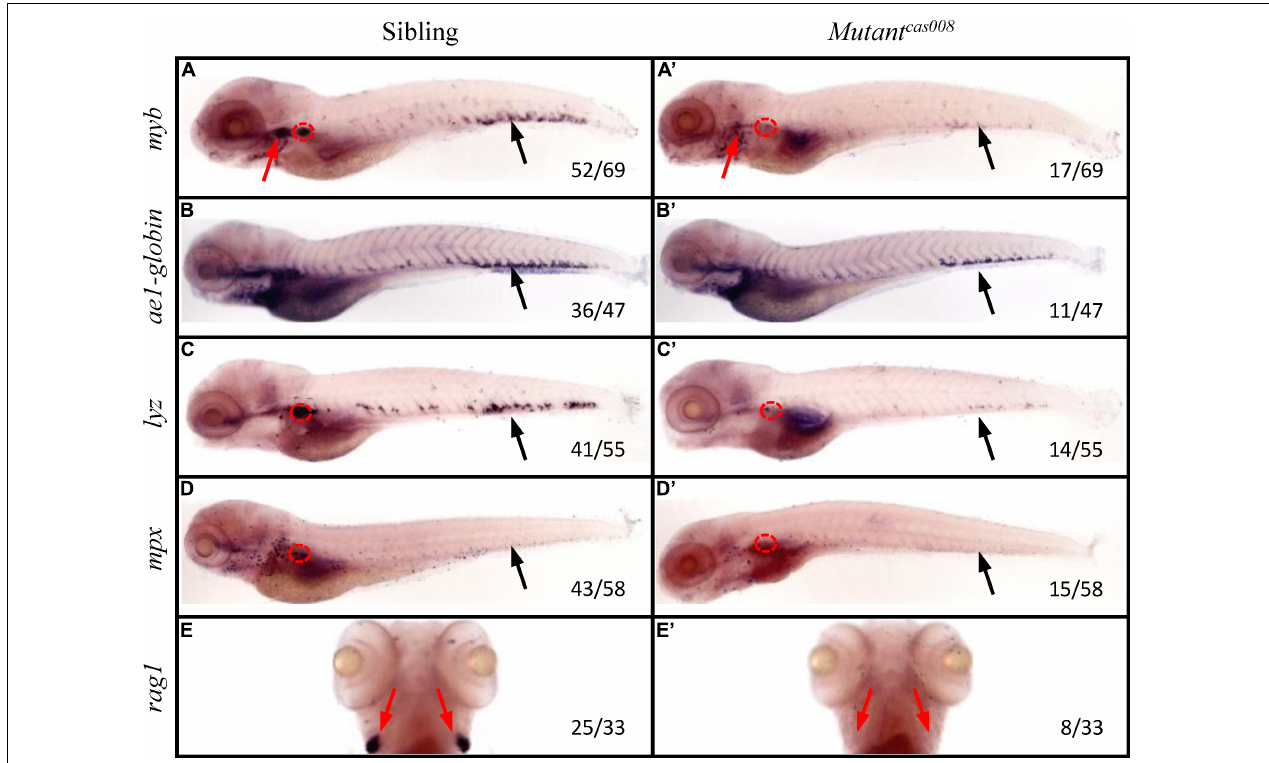
FIGURE 1 | The mutant cas 008 line showed defective definitive hematopoiesis. WISH analysis of myb (A,A (cid:48) ) , ae1-globin (B,B (cid:48) ) , lyz (C,C (cid:48) ) , mpx (D,D (cid:48) ) , and rag1 (E,E (cid:48) ) expression in sibling (A–E) and mutant cas 008 (A (cid:48) –E (cid:48) ) embryos at 5 dpf. The penetrance of the indicated phenotype is shown in the bottom right of each panel. Black arrows indicate the position of CHT, while red arrows and circles show the position of thymus and kidney,